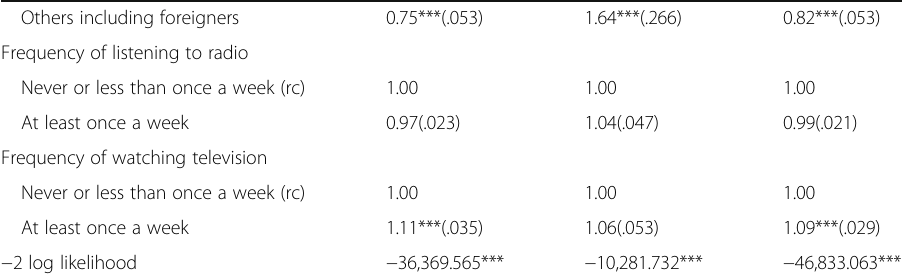
Table 3 Multivariate odds ratio of assessing demographic and socioeconomic characteristics on agreement with wife-beating by husbands among Nigerian women, 2003, 2008, and 2013 Nigeria Demographic and Health Survey